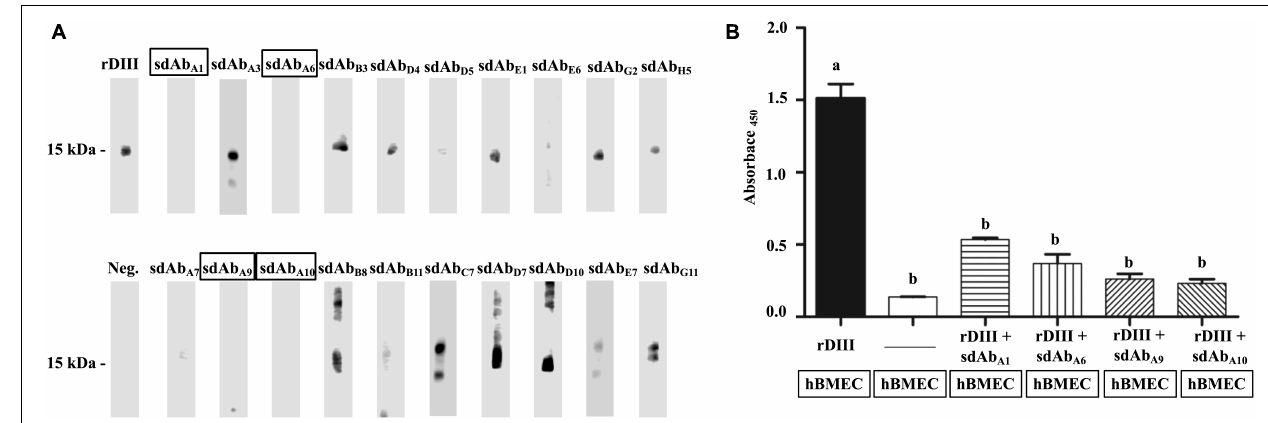
FIGURE 3 | sdAb targeting the DIII blocked the interaction between rDIII and human brain microvascular endothelial cells (hBMECs) proteins. (A) NC strips transblotted with hBMEC proteins were incubated with either rDIII (positive control) or rDIII pretreated with sdAbs targeting receptor binding motifs of DIII. sdAb used to pretreat rDIII are mentioned on each NC strip. The interaction between rDIII/pre-treated rDIII and hBMEC proteins at ∼ 15 kDa was detected by HisProbe-HRP conjugate and chemiluminescent HRP substrate in Western blot analysis. sdAbs blocking the rDIII-hBMEC interaction showed the absence of chemiluminescent HRP signal at 15 kDa is framed. For negative control (Neg.), NC strip of hBMEC protein was precluded with the incubation of rDIII in the same Western blot assay, and no signal was detected. (B) The ability of sdAb A1 , sdAb A6 , sdAb A9 , and sdAb A10 to block the interaction between rDIII and hBMECs was detected through cell ELISA. rDIII alone (positive control) or aforestated sdAbs-treated rDIII was incubated on paraformaldehyde-fixed hBMECs on the ELISA plate. The interaction was detected by HisProbe-HRP conjugate and UltraTMB-ELISA substrate. hBMECs precluded with the addition of either rDIII or sdAbs served as a negative control. Antigens and sdAbs added on fixed hBMECs in ELISA plate (framed) are mentioned below each bar graph. A significant difference between the compared treatments by one-way ANOVA ( p < 0.05) is indicated by different alphabets.